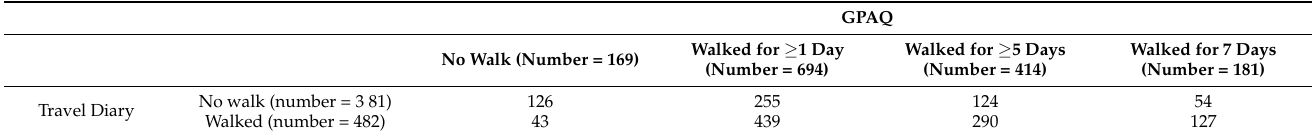
Table 5. Walking in the travel diary compared to walking in the GPAQ.